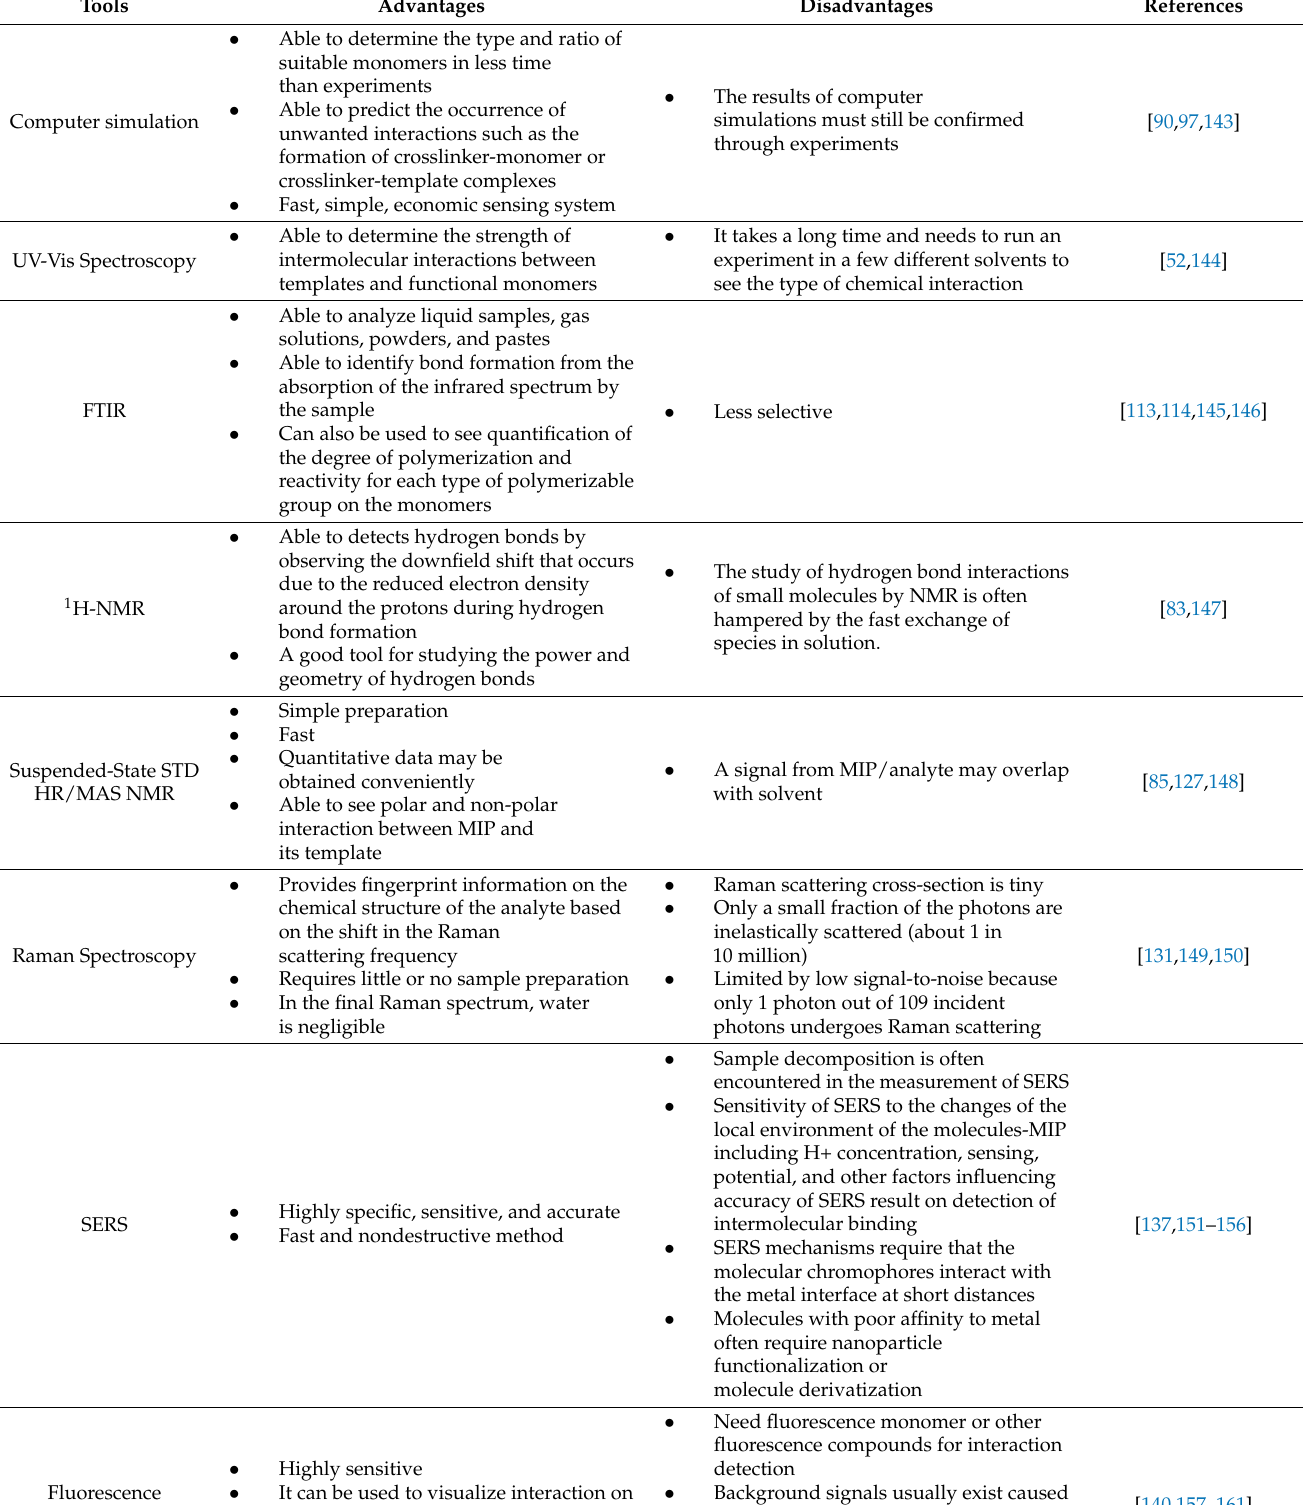
Table 2. Method Comparison for detecting interactions template-monomer and MIP-template.